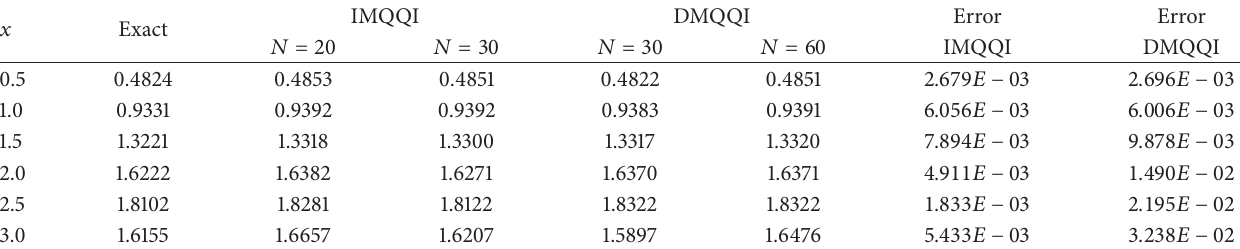
ers’ equation and the modified Kadomtsev-Petviashvili